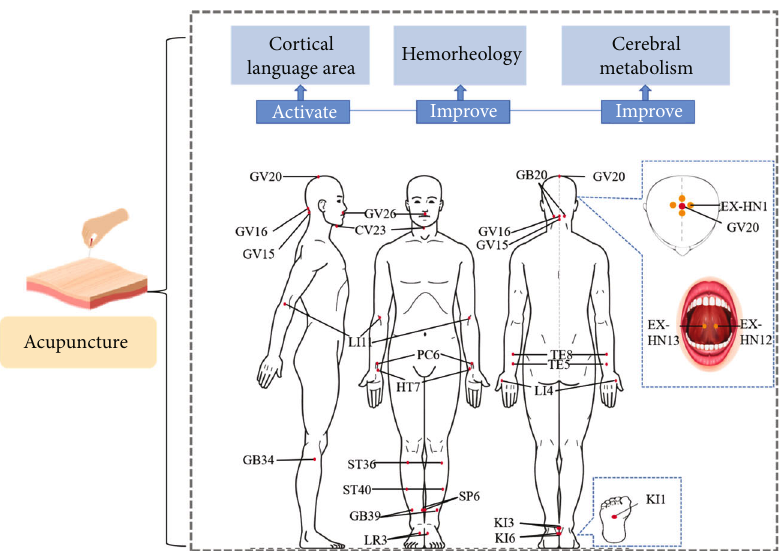
Figure 3: E ff ect of acupuncture in PSA patients. When acupuncture acts on acupoints, it will a ff ect the recovery of aphasia from the cortical language area, hemodynamics, and brain metabolism. GV20: Baihui; EX-HN1: Sishencong; GV26: Shuigou; GV15: Yamen; GV16: Fengfu; GB20: Fengchi; EX-HN12: Jinjin; Yuye: EX-HN13; CV23: Lianquan; SP6: Sanyinjiao; ST40: Fenglong; ST36: Zusanli; LR3: Taichong;